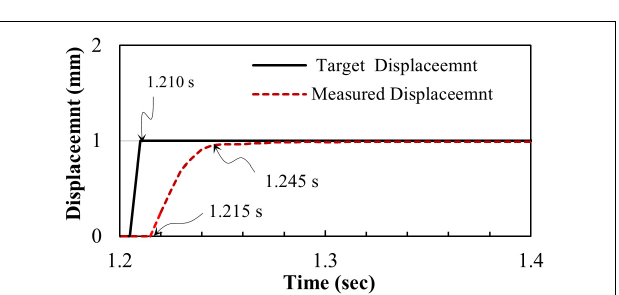
FIGURE 4 | Response of the motor to the pulse